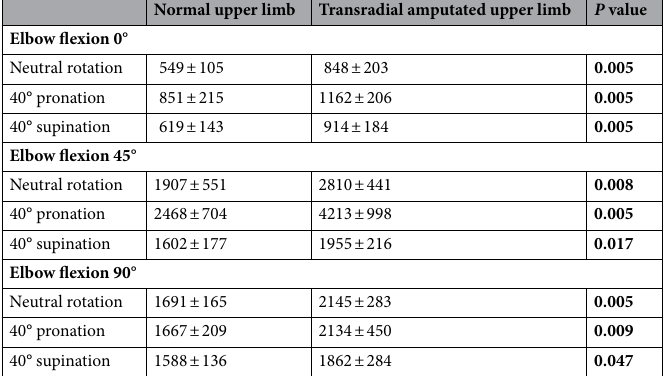
Normal upper limb Transradial amputated upper limb P